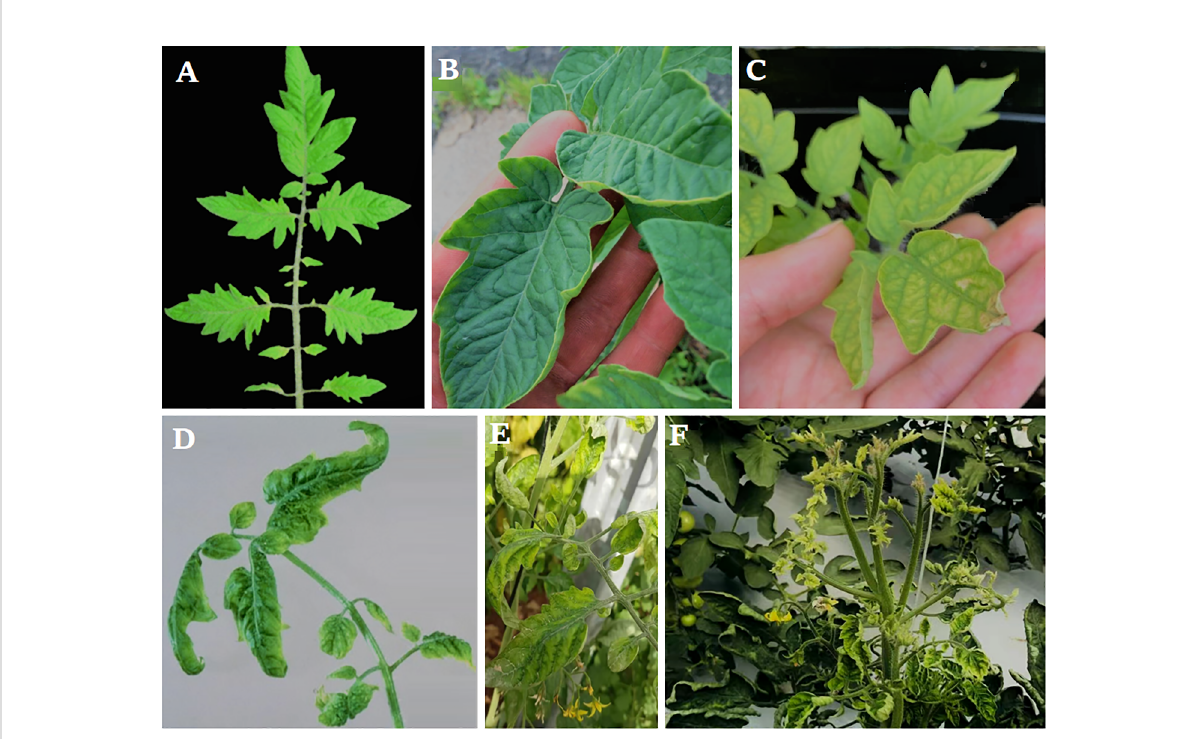
FIGURE 2 Typical symptoms of TYLCV, (A) Normal plant showed no infection, (B) Infection at a very early stage between 2 to 4 weeks post-infection, (C) tomato plant after fi ve weeks infection, (D – F) Infection at a late stage where the plants show severe symptoms consisting of marked yellowing, puckering, and severe size reduction in the top